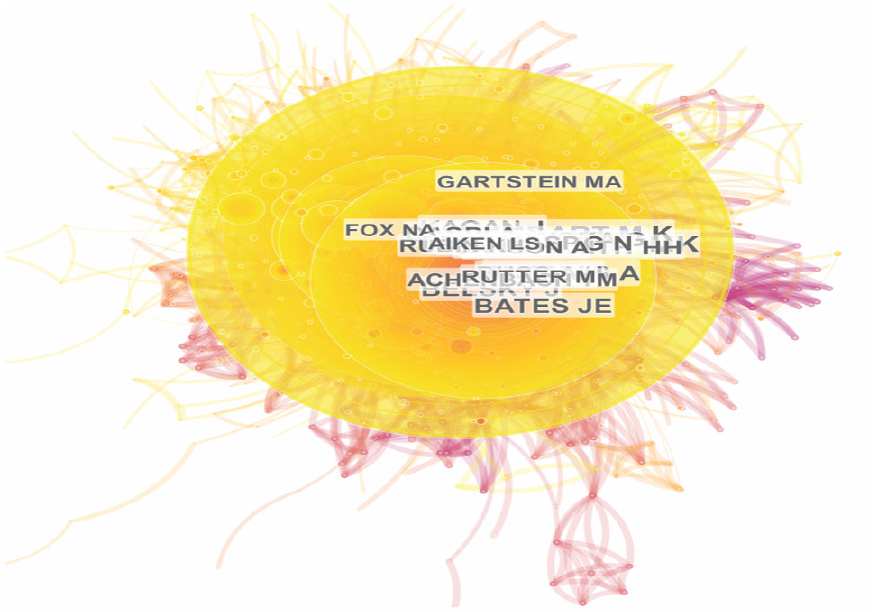
Figure 4 . The Network Structure of Citations by